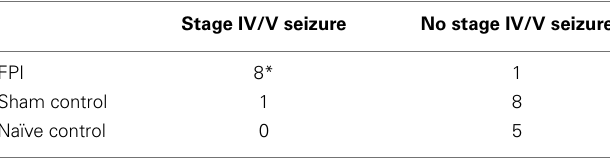
Table 1 | Chi-Square results from contingency table analysis of stage IV/V seizures.